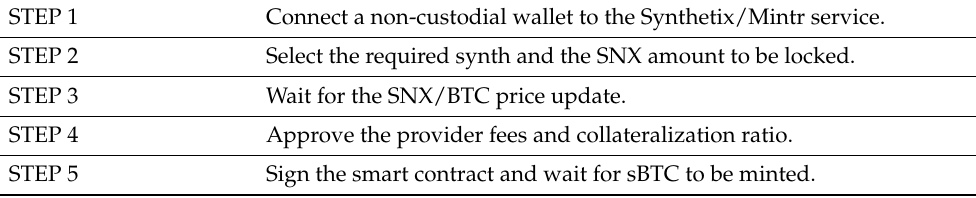
Table 5. Minting sBTC process (before VEGA update) *.